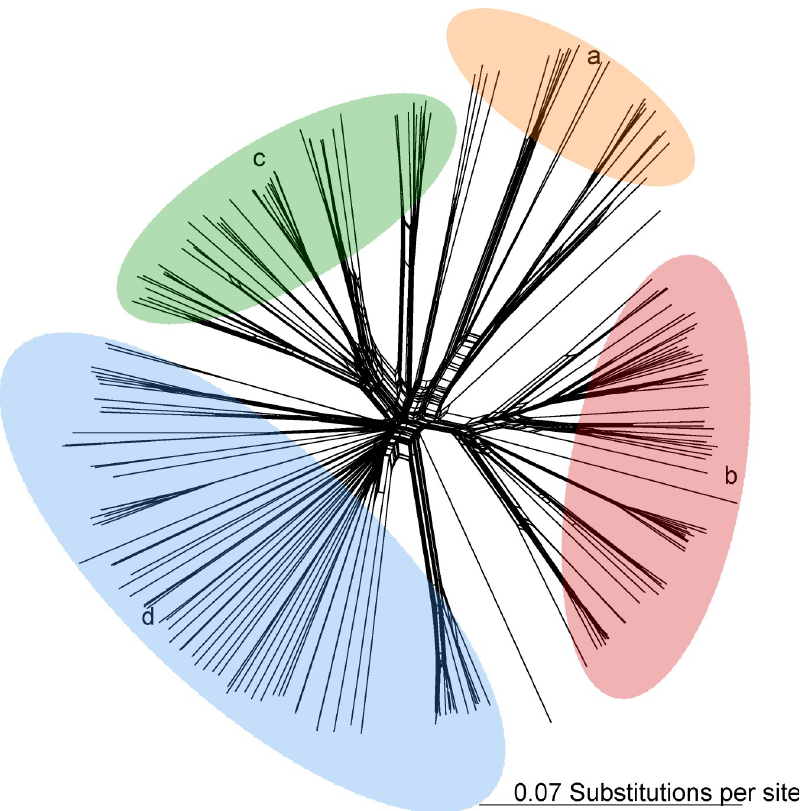
Fig 2. Neighbor-net tree of single nucleotide polymorphism genotypes from 220 M . bovoculi genotype 1 strains. Letters, ellipsoids and colors denote subtypes from Fig 1.